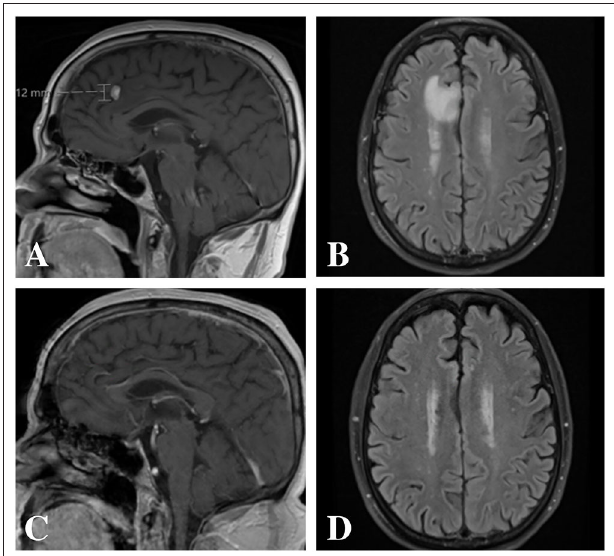
FIGURE 1 | Magnetic resonance imaging pre- and post-treatment. (A,B) Pre-treatment imaging demonstrated an avidly enhancing 11 × 7 × 12mm lesion along the mesial surface of the right frontal lobe within the cingulate sulcus with surrounding vasogenic edema. (C,D) Post-treatment imaging with complete radiographic resolution of the lesion and associated vasogenic